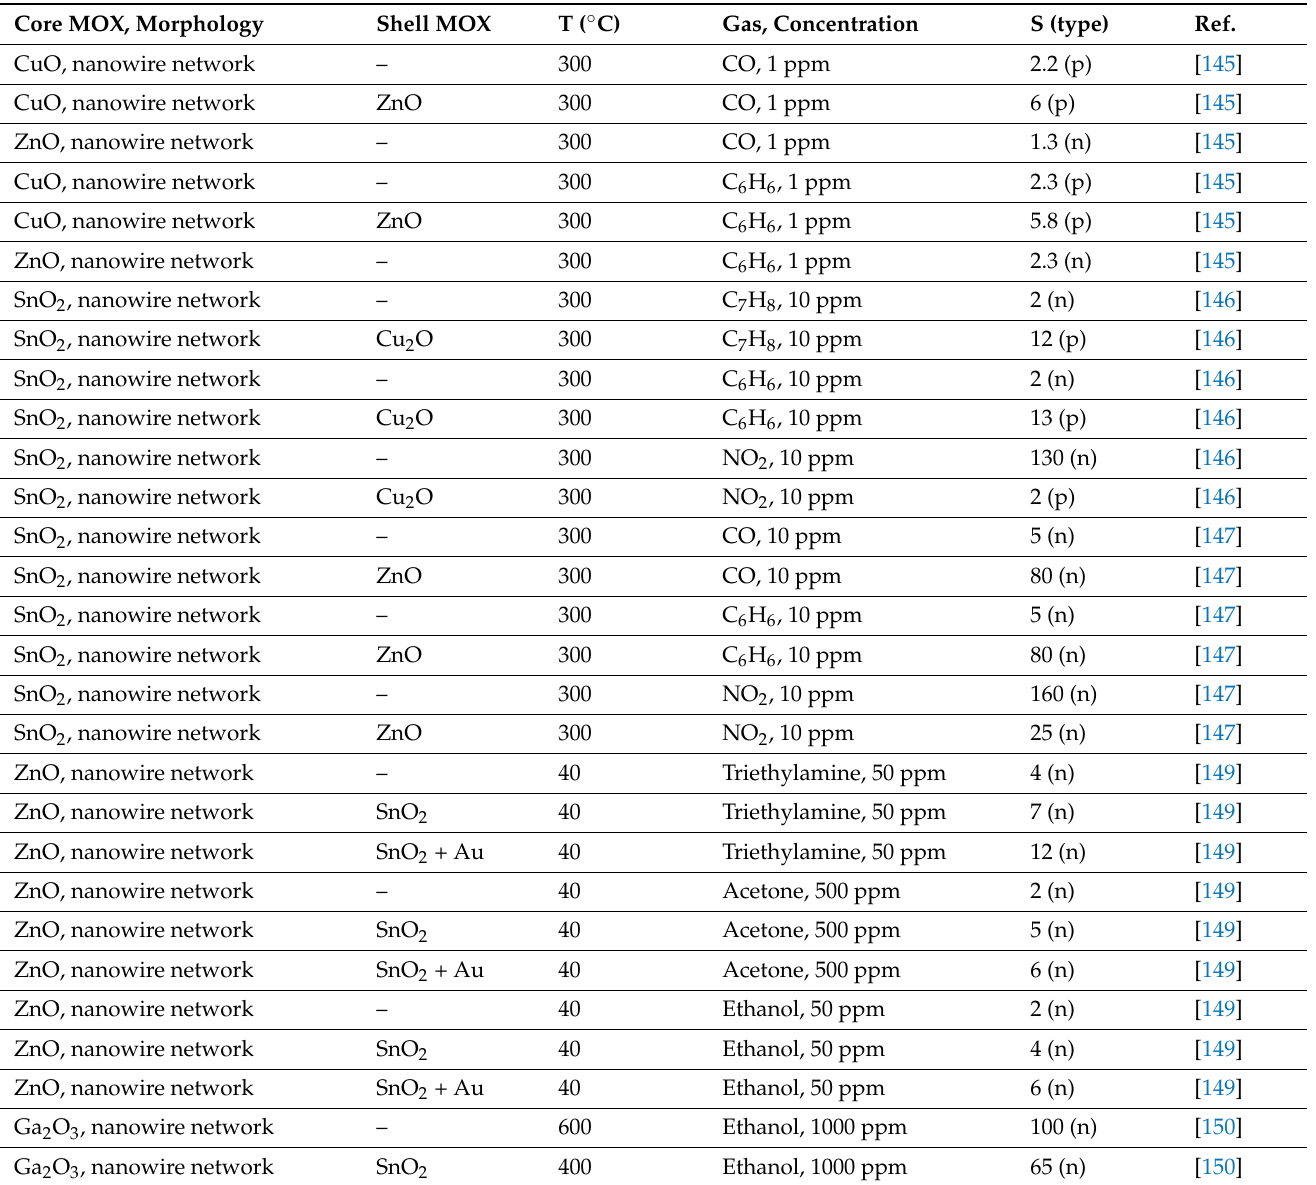
Table 4. Chemiresistors based on metal oxide (MOX) core–shell nanostructures. The response intensity S is calculated as S = R gas /R air for NO 2 and as S = R air /R gas for other compounds in the case of n-type sensing response. The contrary is in the case of p-type sensing response. The n- or p- type response is reported in the S column. Gas concentrations are expressed in parts per million (ppm) and the sensor temperature is